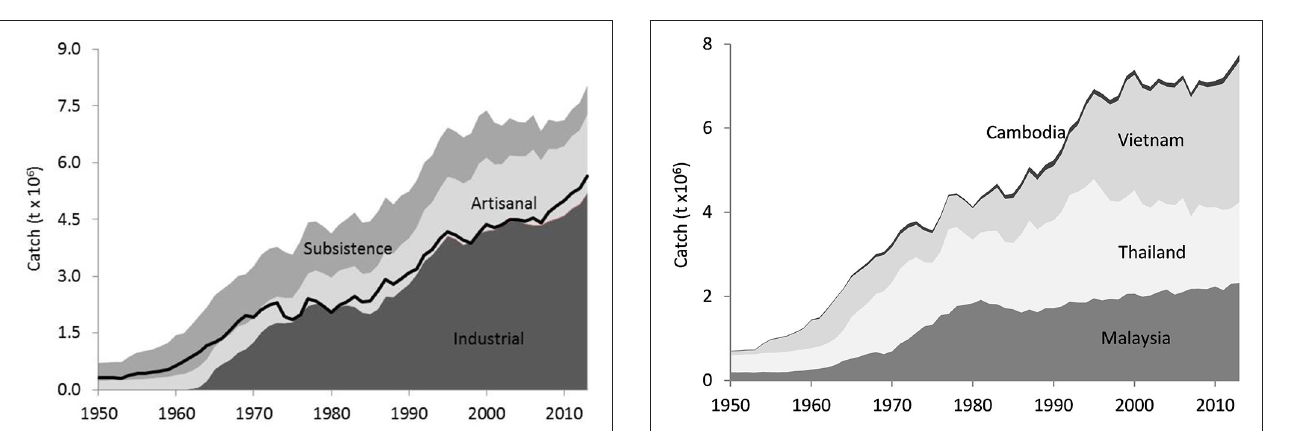
FIGURE 1 | Total reconstructed catch of Cambodia, Malaysia, Thailand, and Malaysia showing the contribution of different sectors. The solid line indicates reported catch. Recreational catches are too small to appear on this graph.